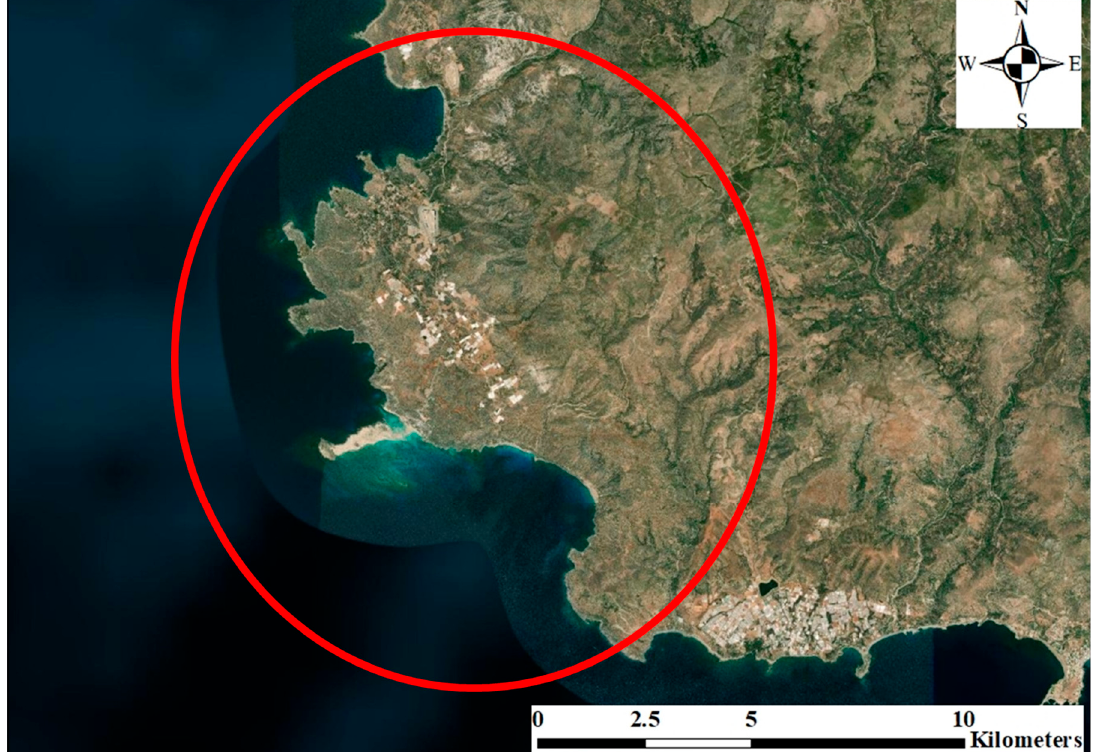
Figure 1. The location of the study area in Crete Island, Greece.